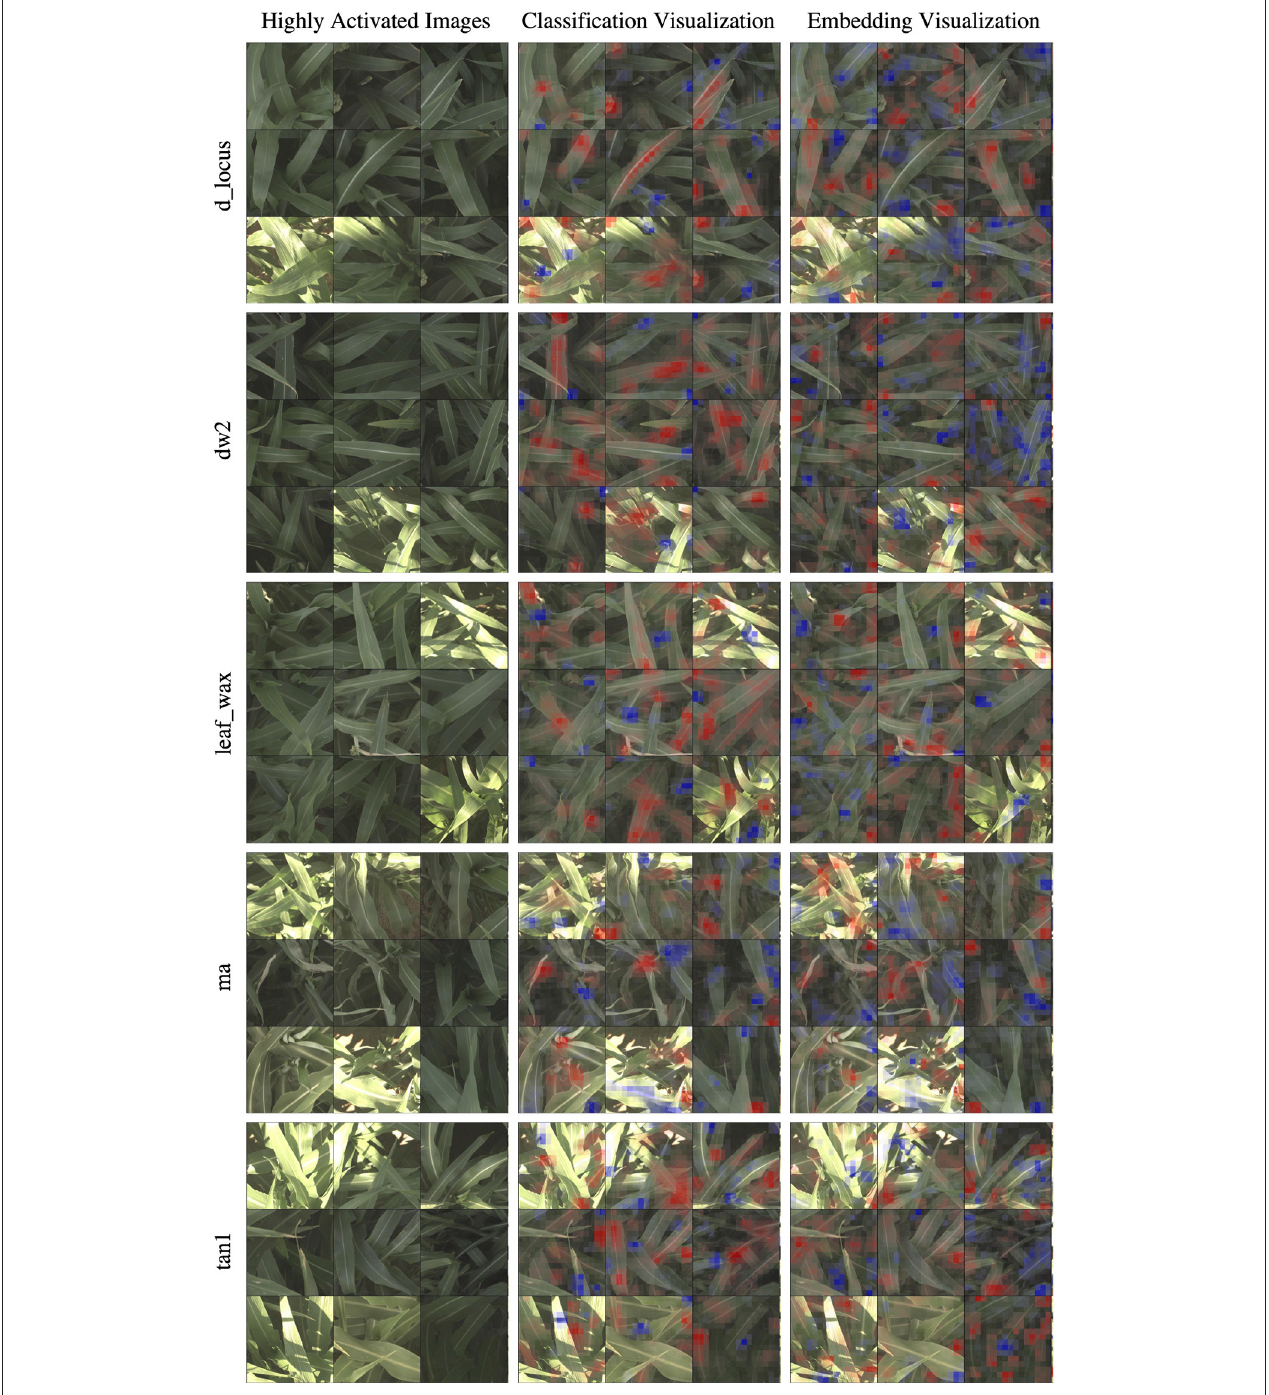
FIGURE 6 | In this figure, we compare the “reference” visualizations from the classification and embedding models over all of the markers. Features highlighted in red are those that led the network to make its correct classification, while features in blue are those which detracted from the correct classification. In general, the classification visualizations focus on specific and more readily identifiable features, while the embedding visualization appears to encompass more diverse but less obvious features. Specific examples of this for the d_locus marker are highlighted in Figure 7 .